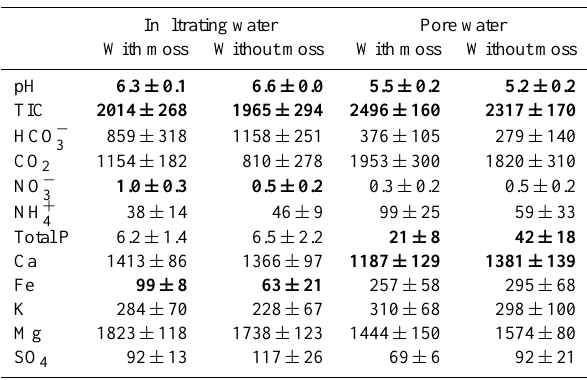
Table 2. Infiltrating water and pore water characteristics. All nu- trient concentrations are given in µmolL − 1 . Overall averages are given, while statistical tests were carried out over time using linear mixed models (LMMs). When these LMMs showed significant dif- ferences between moss covered and bare soils, values are given in